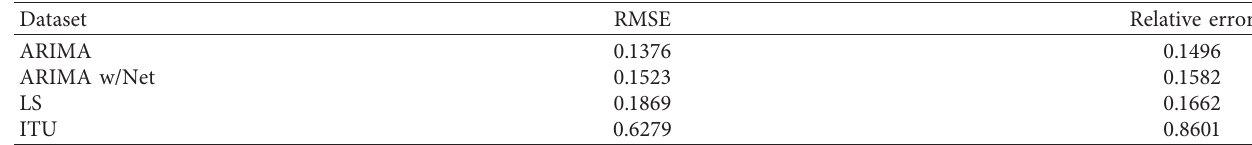
Table 13: ARIMA, ARIMA with neural network, LS, and ITU errors for “data2.”